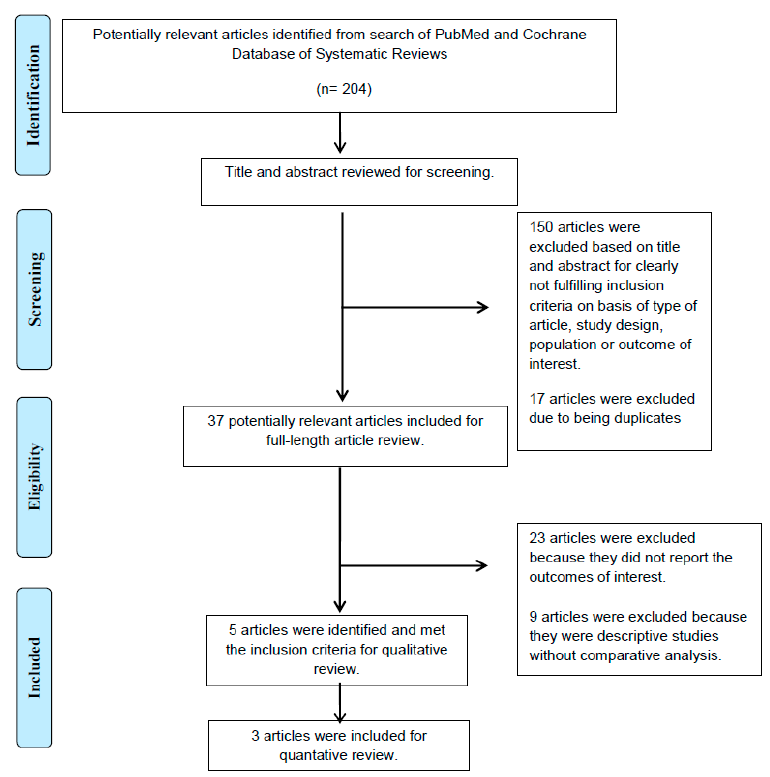
Figure 1. The literature retrieval, review, and selection process. Table 1. The characteristics and quality assessment of the included studies.